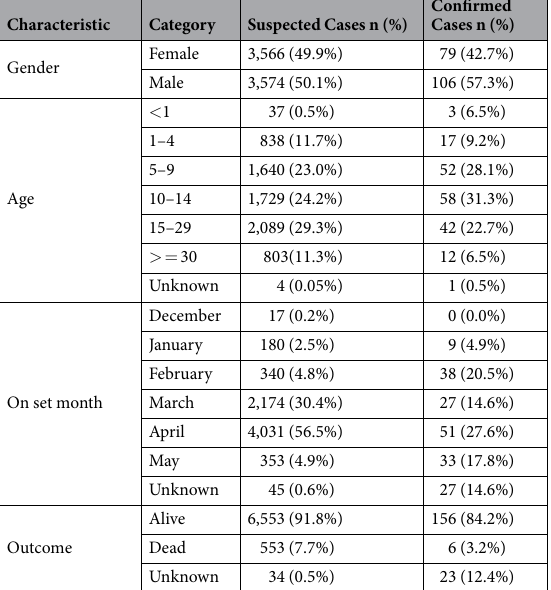
Table 1. Baseline characteristics of patients with suspected and confirmed meningitis in Zamfara